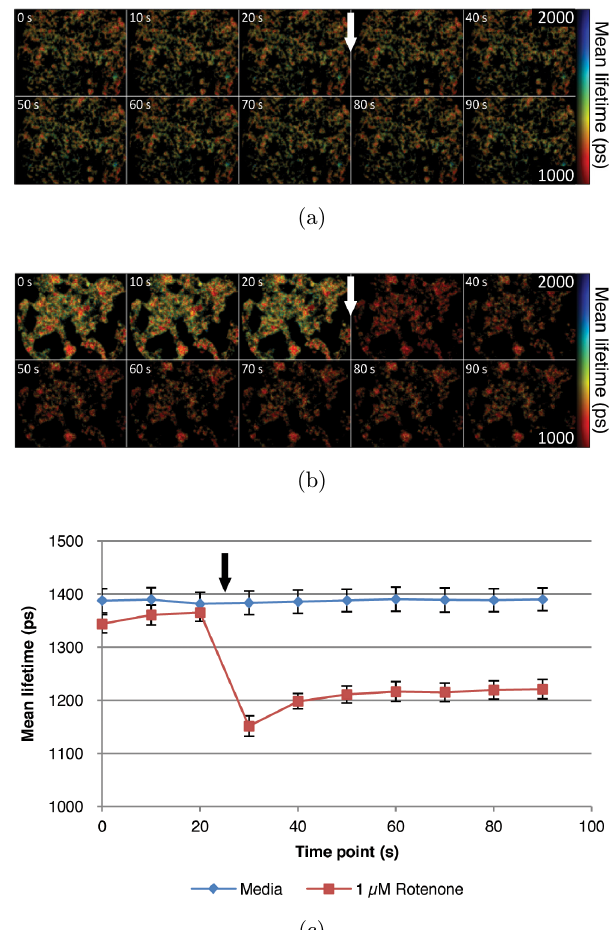
Fig. 5. Results showing e®ect of 1 (cid:1) M rotenone on MCF7 cells. (a) Intensity merged mean lifetime images across time points from a single well, with control media added after third time point as illustrated. (b) Intensity merged mean lifetime images across time points from a single well with rotenone being added after third time point ( scale bar ¼ 100 (cid:1) m). (c) Mean ¯tted lifetimes across six wells of each condition plotted against time point. Arrow indicates addition of control media or rotenone; error bars show standard errors calculated across repeat wells.